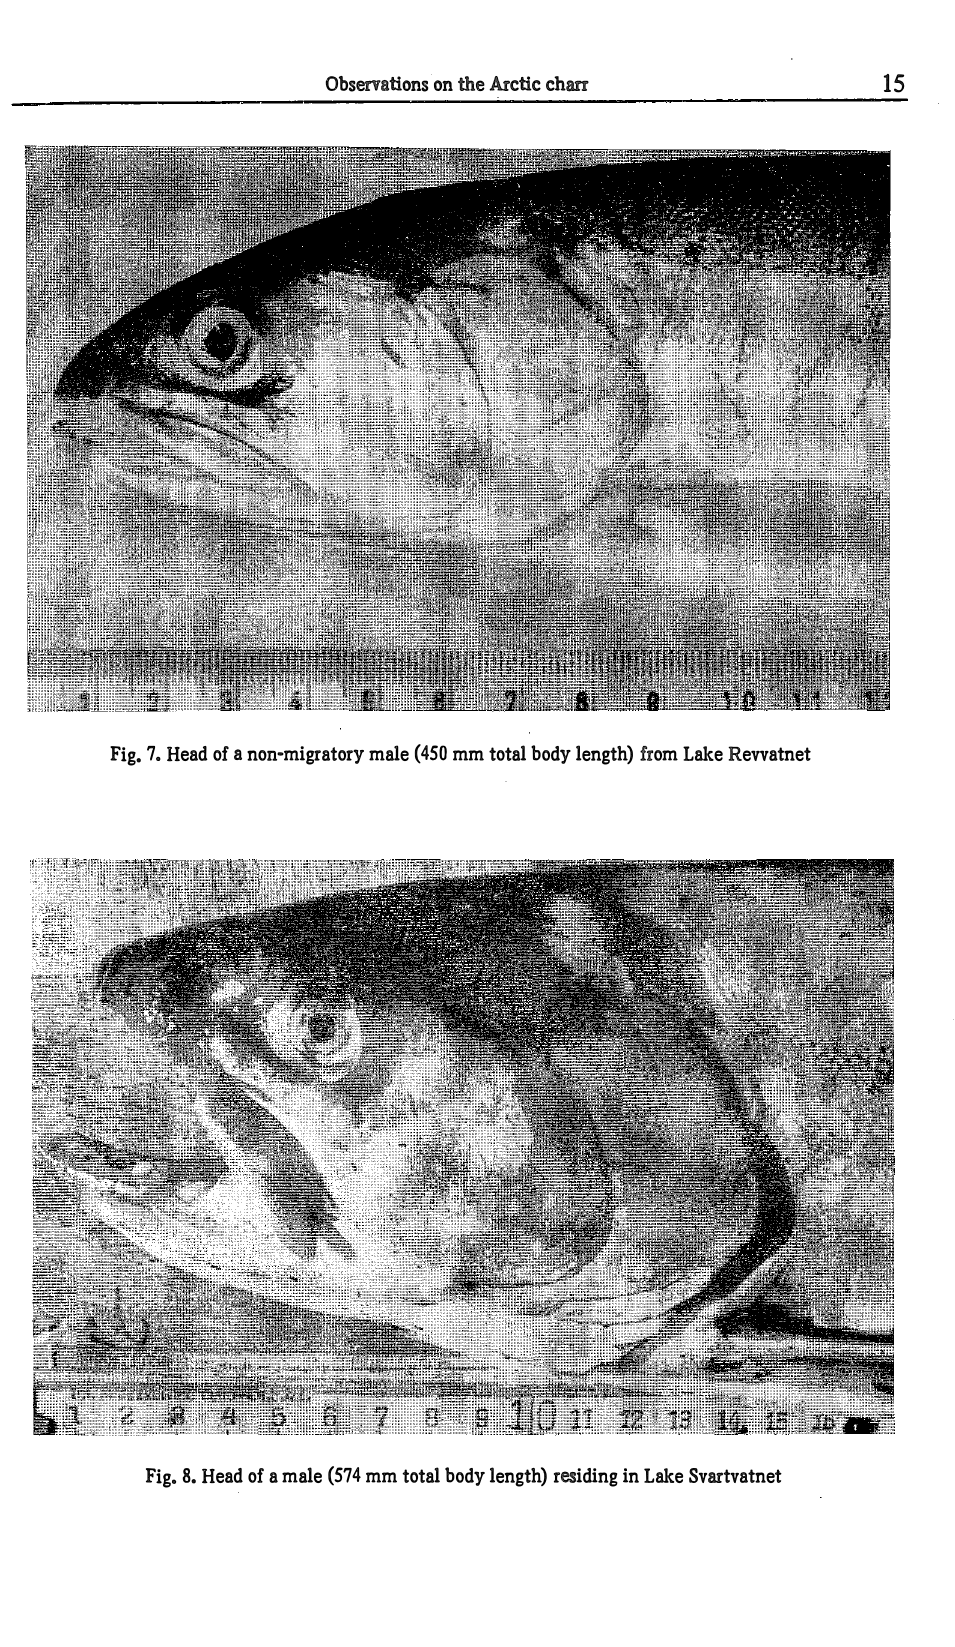
Fig. 8. Head of a male (574 mm total body length) residing in Lake